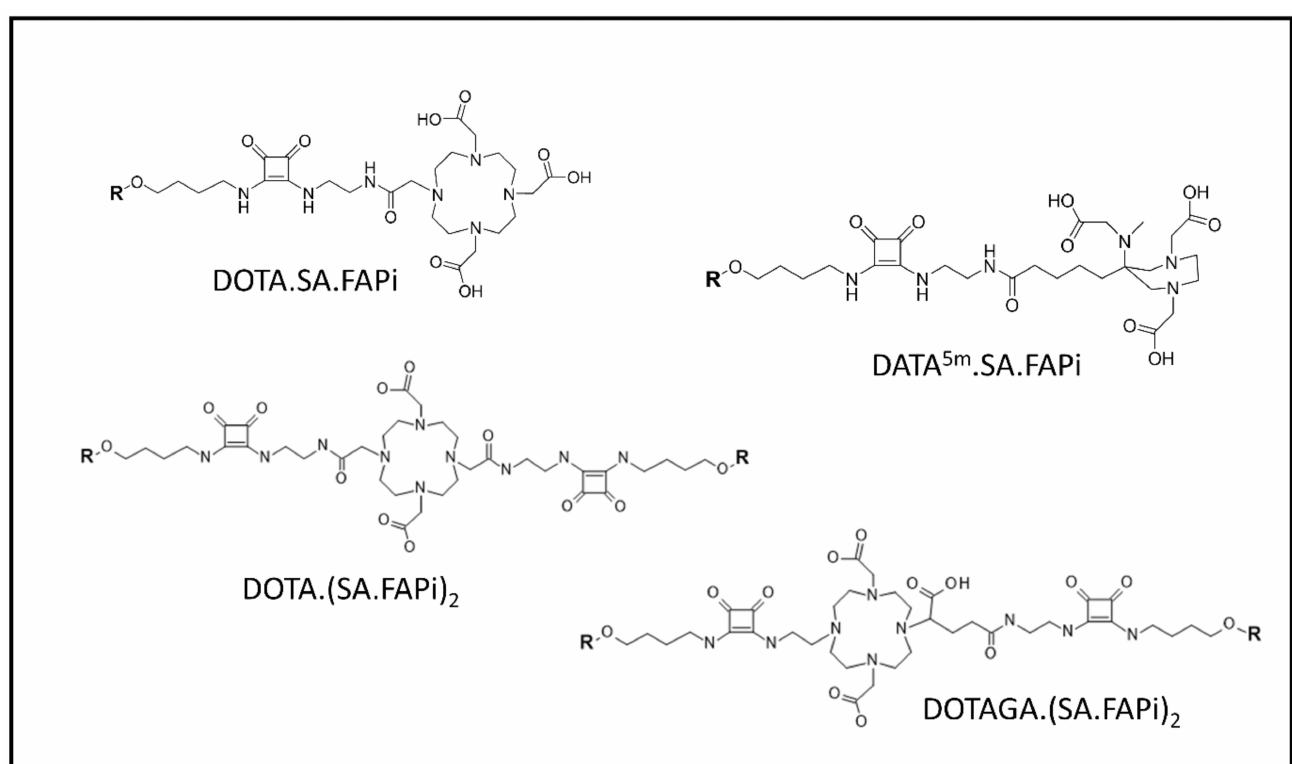
Figure 7. FAPI molecules developed by the Mainz research group: DOTA.SA.FAPi, DATA 5m .SA.FAPi, DOTA.(SA.FAPi) 2 , and DOTAGA.(SA.FAPi) 2 . ‘R’ represents UAMC1110